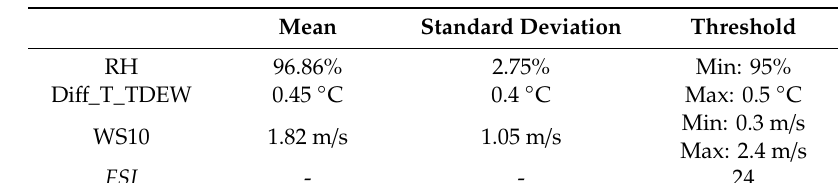
point depression and wind speed measured in fog condition and FSI threshold calculated using Youden’s